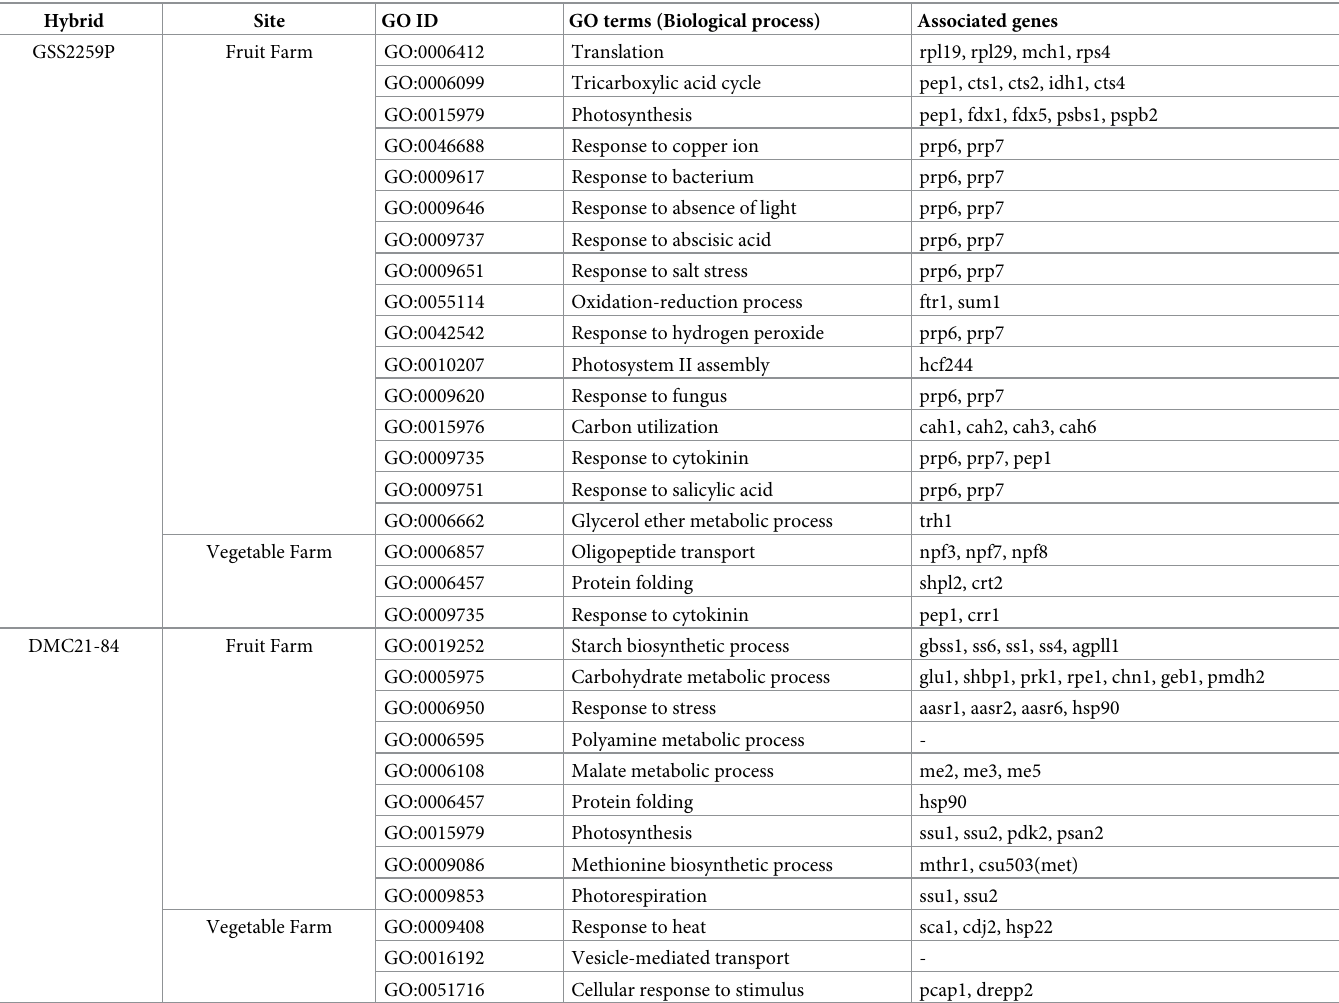
Table 3. Over-represented biological processes of DEGs involved in crowding stress on each hybrid and associated genes.